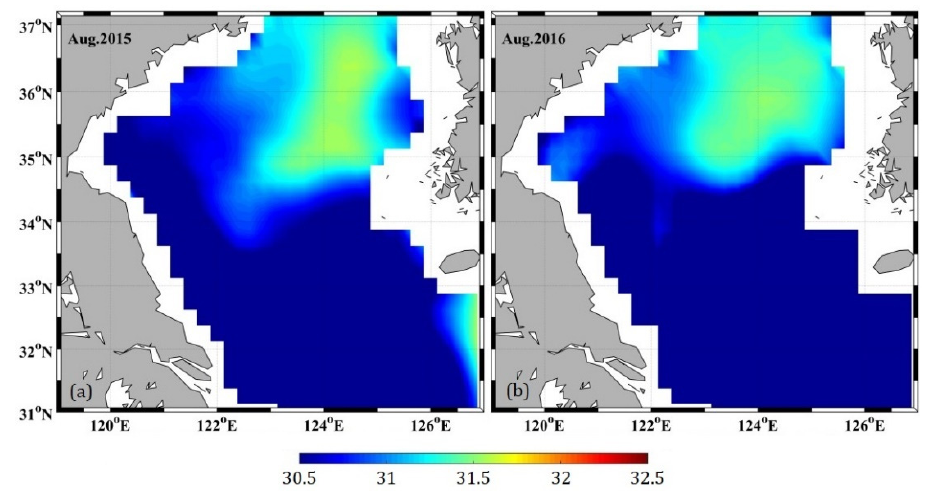
Figure 9. Spatial distributions of sea surface salinity produced by SMAP satellite products for ( a ) August 2015 and ( b ) August 2016.